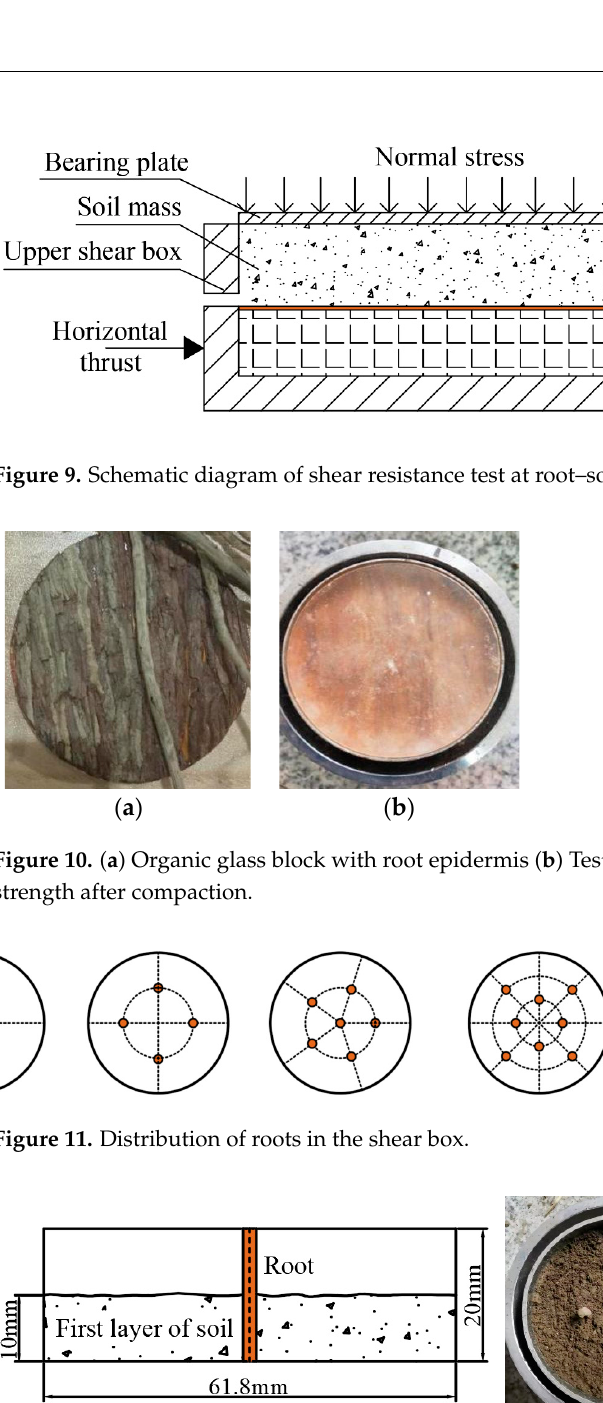
Figure 12. Preparation of root-permeated soil sample with δ of 90° (RAR0.21% as an example). Table 2. Number of specimens for bond strength of root–soil interface.